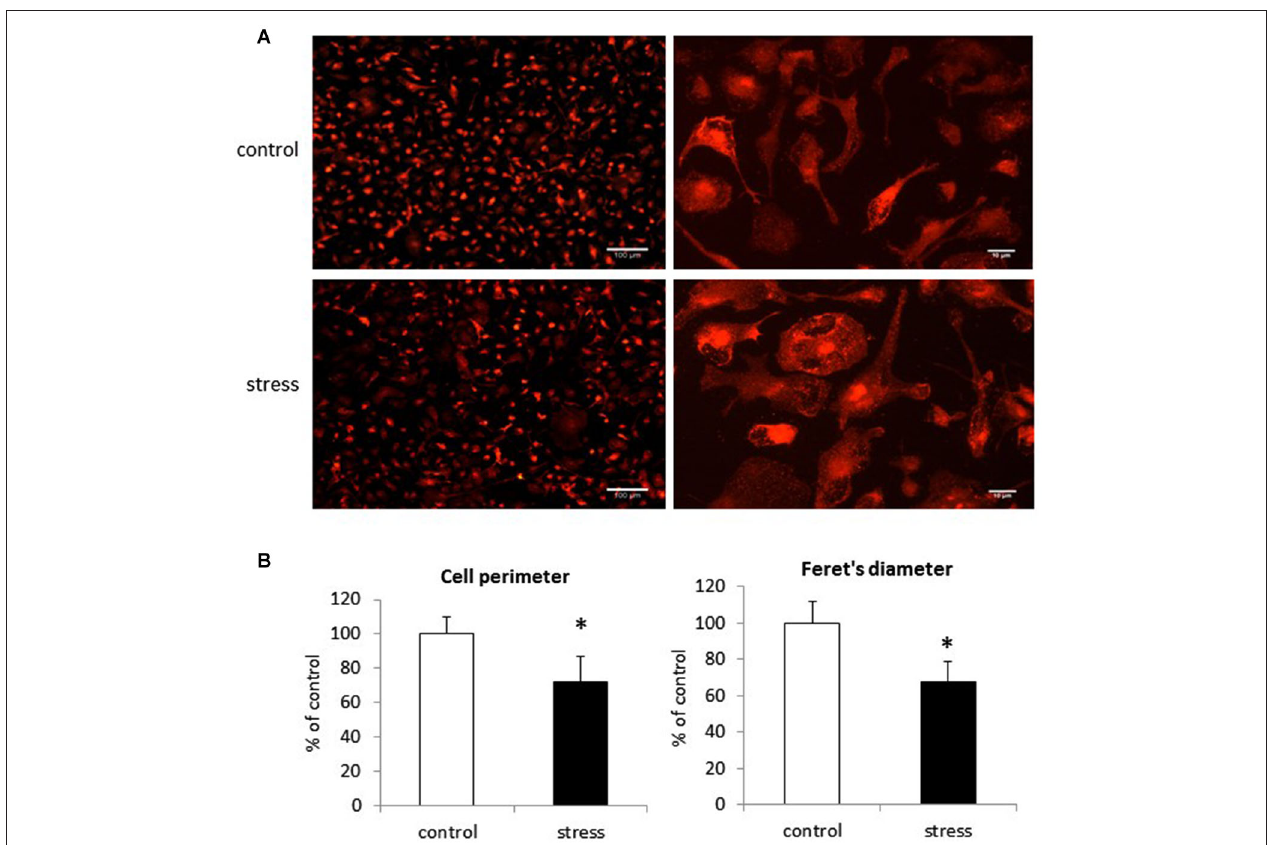
microglia morphology changes: perimeter and Feret’s diameter. The results are presented as % of control ± SD, n = 6 in each group, * p < 0.05; one-way ANOVA.